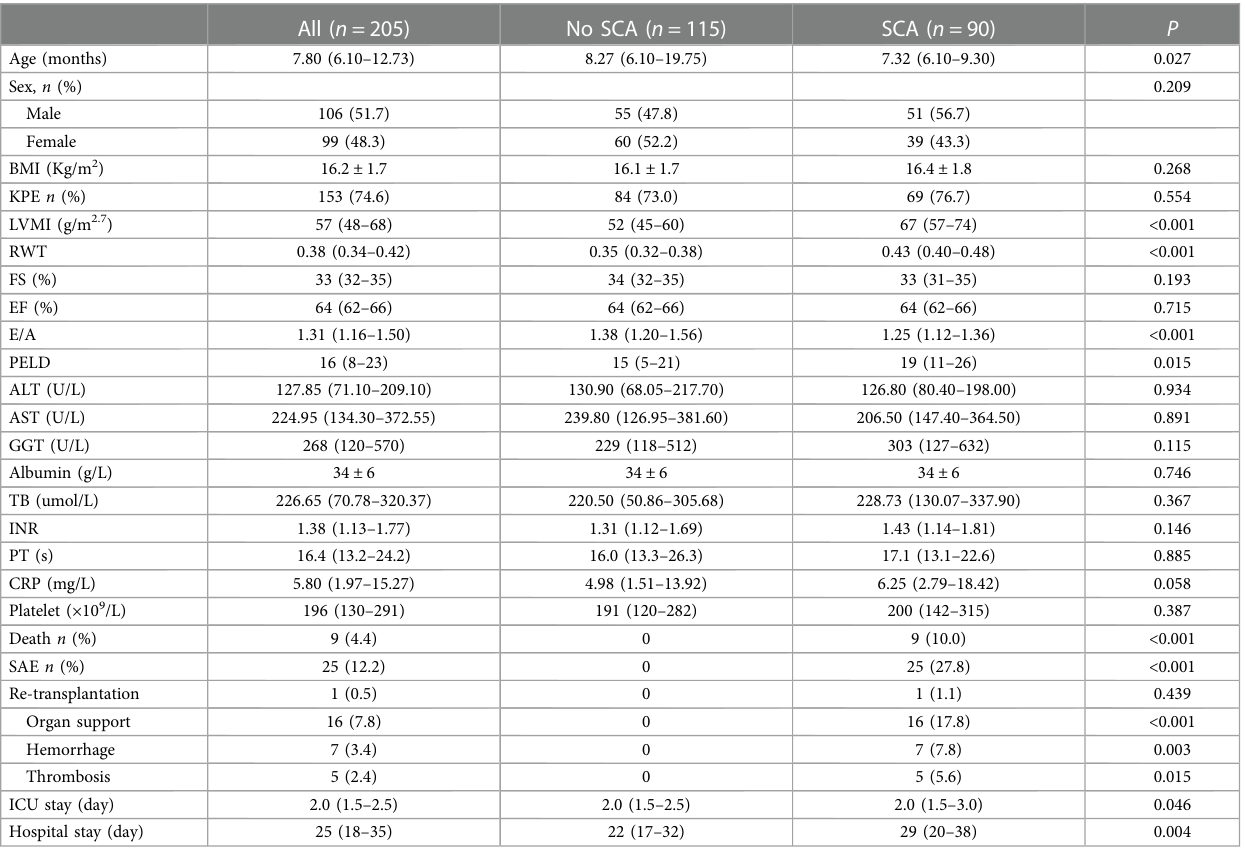
TABLE 4 Comparison of characteristics between patients with and without SCA.